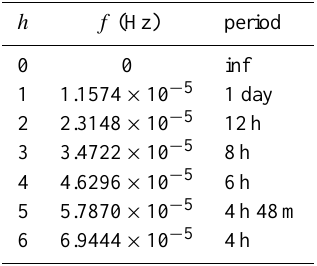
Table 2. Frequencies of the 7 lowest harmonics of data of 1 day.